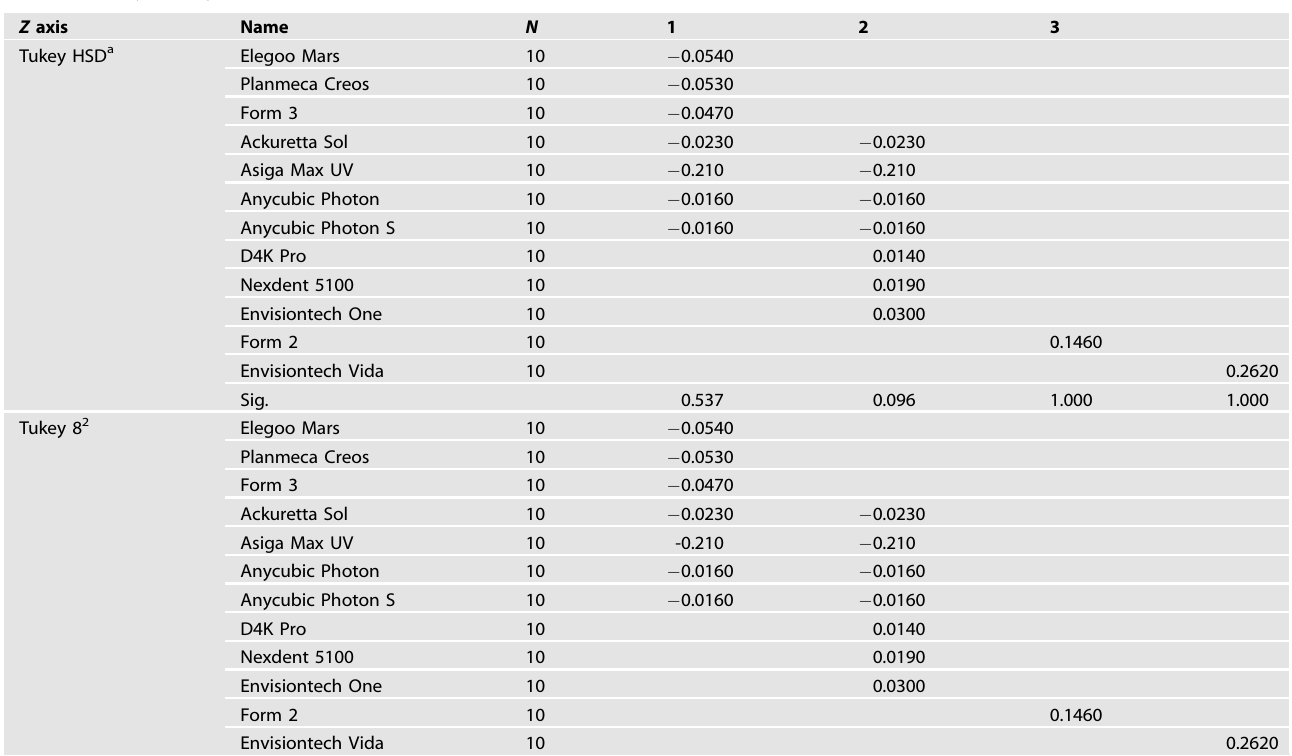
Means for groups in homogeneous subsets are displayed. a Uses harmonic mean sample size = 10.000; subset for alpha =